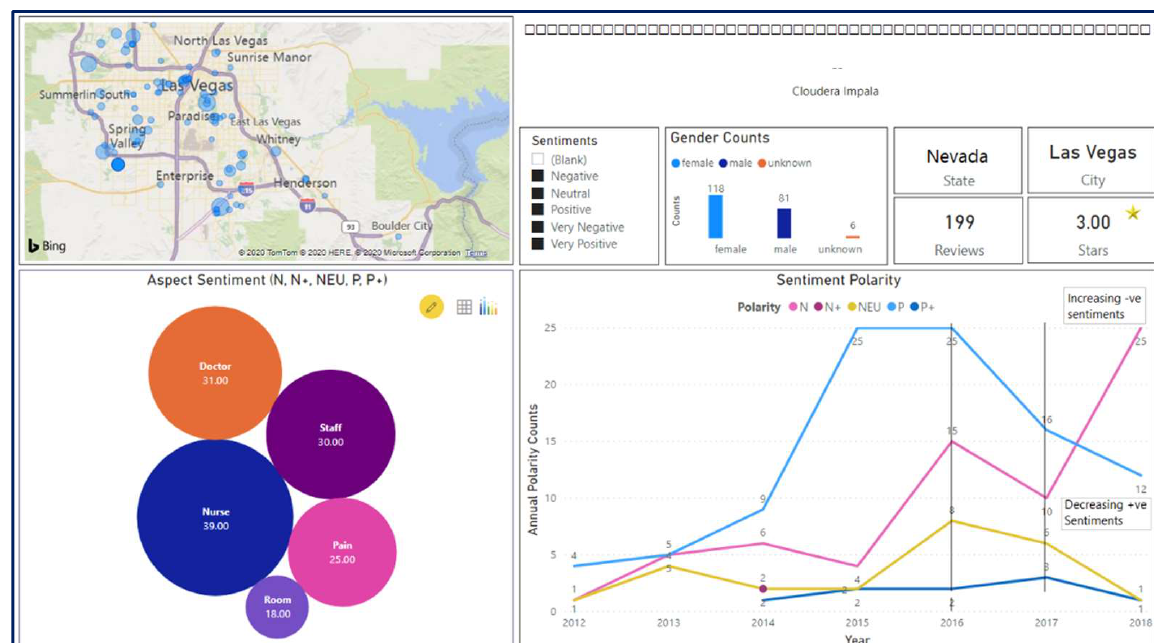
Figure 11. Analysis presentation (positive sentiment aspects).